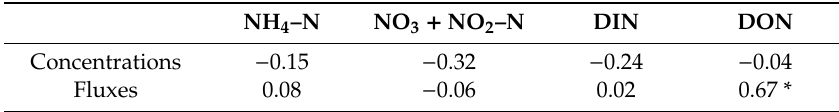
Table 2. Spearman correlations between rainfall (mm) and average monthly concentrations of dissolved nitrogen (mg L –1 ) or average fluxes of dissolved nitrogen (kg N ha –1 episode –1 ) in bulk precipitation ( n = 21). DIN = Dissolved inorganic nitrogen; DON = Dissolved organic nitrogen.